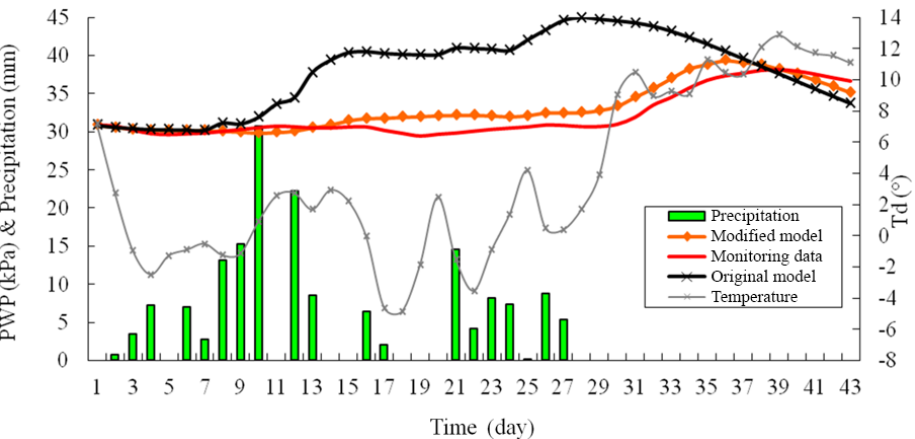
Figure 11. Estimation of the change of PWP using the original tank model and our modified tank model (snowmelt + time lag 1 + 2) in the snowmelt season (4 March–15 April 2009).